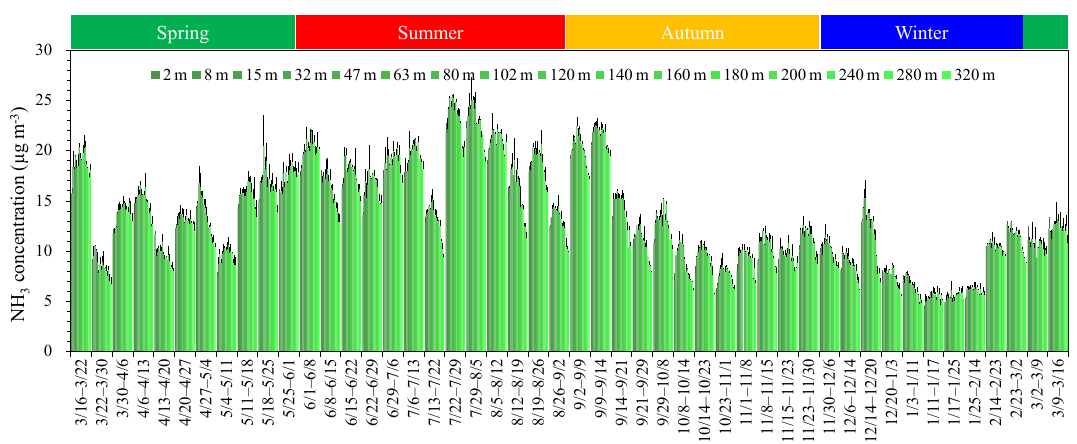
Figure 2. Time series of the vertical distribution of weekly atmospheric NH 3 concentrations ( ± 1 σ ) in Beijing urban (16 March 2016– 16 March 2017).